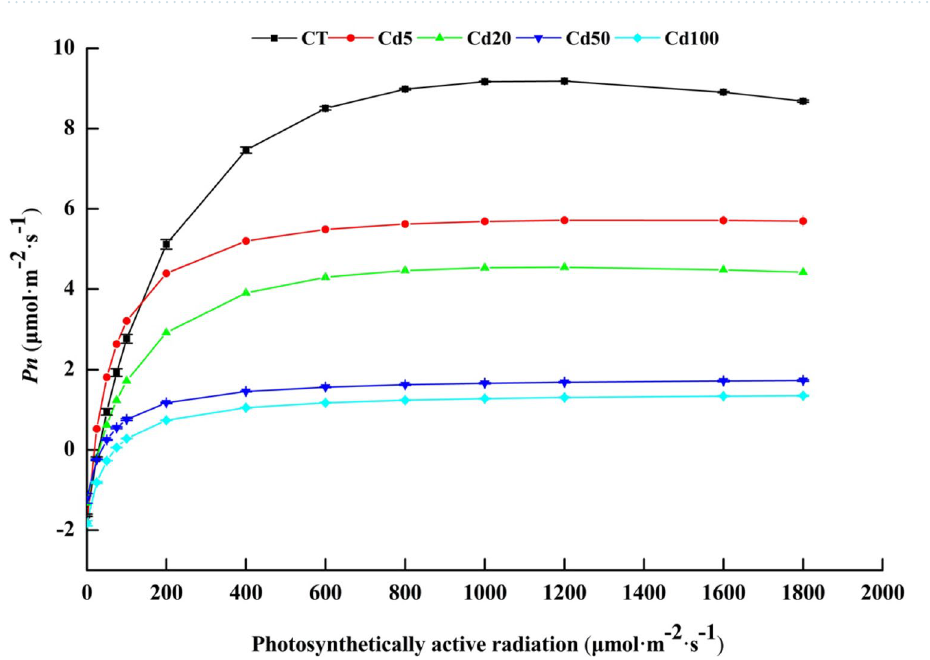
Figure 6. Photosynthetic light-response curves of sassafras leaves under the different cadmium stress